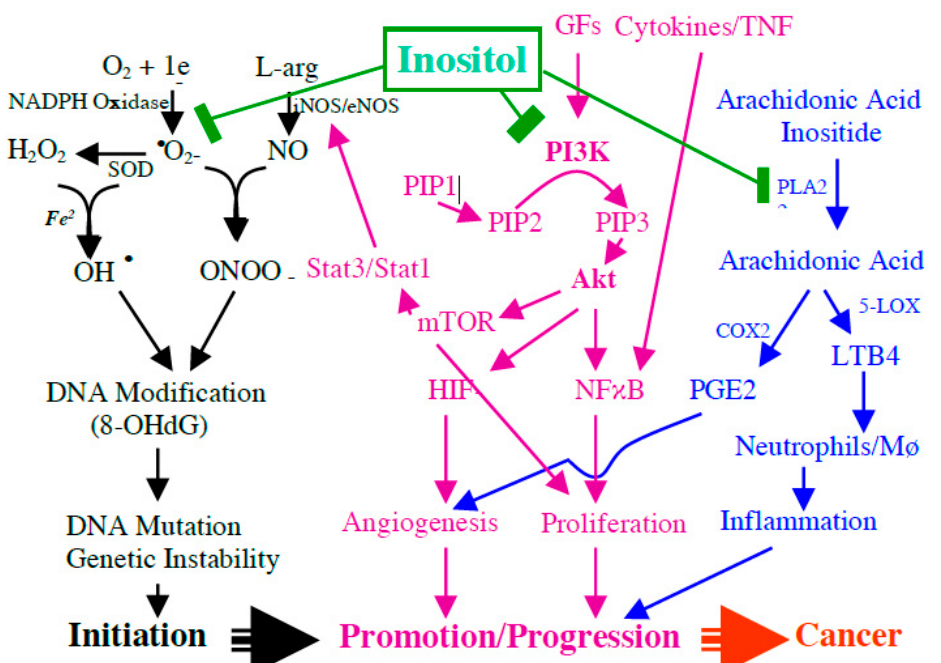
Figure 1. Potential mechanism of inositol on blocking the key biologic events in inflammatory process in inflammatory bowel disease (IBD), including IBD-caused free radicals, myo -inositol (1,4,5)-trisphosphate (IP3)-mediated AKT (protein kinase B) signaling, phospholipase A2/inositol-arachidonic acid metabolic pathway, and active eicosanoids, and blocking these key biologic events is crucial in inhibiting DNA damage/genetic instability, cell proliferation, and angiogenesis, and IBD-induced carcinogenesis.